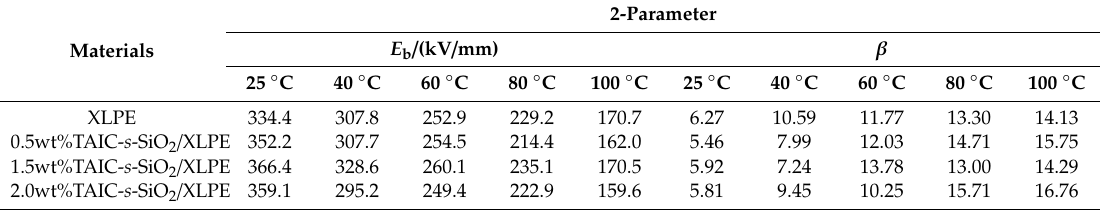
Table 2. Characteristic breakdown field E b at 63.2% probability and shape parameter β obtained by fitting the DBS experimental data with 2-parameter Weibull distribution at 95% confidence interval.